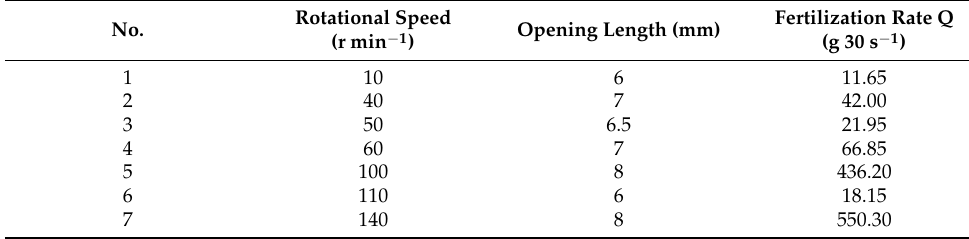
Table 5. Test samples of segment A.